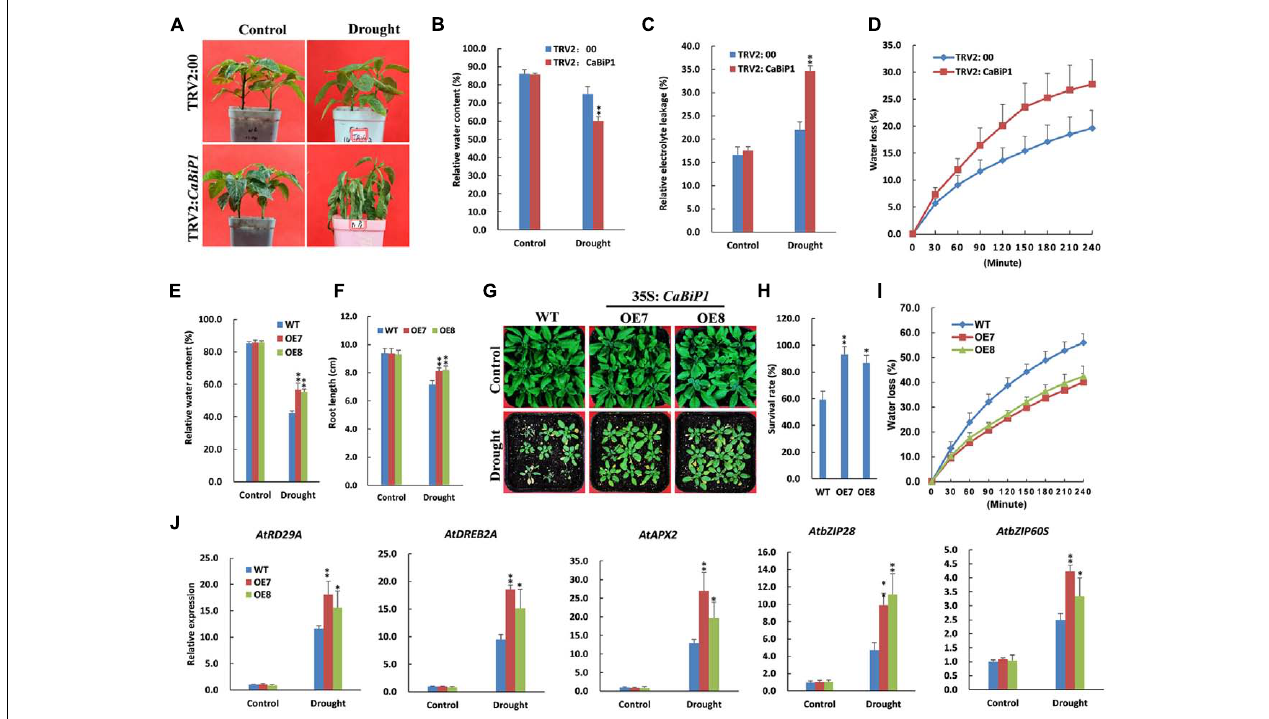
FIGURE 10 | Altered drought tolerance in CaBiP1 -silenced and CaBiP1 -overexpressing plants. (A–C) Symptoms, RWC and REL in the leaves of TRV2: CaBiP1 and TRV2:00 pepper seedlings grown under drought stress performed by withholding water for 10 days. (D) Water loss rate of detached leaves from pepper TRV2: CaBiP1 and TRV2:00 seedlings. (E,F) RWC and root length of WT and CaBiP1 -OE lines grown under drought stress by withholding water for 12 days. (G,H) Survival rate of WT and CaBiP1 -OE lines grown under drought stress by withholding water for 12 days then rehydrated for 2 days. (I) Water loss rate of detached leaves from WT and CaBiP1 -OE seedlings. (J) Expression of drought stress- and ER stress-related genes in the leaves of WT and CaBiP1 -OE lines grown under drought stress by withholding water for 10 days. AtActin2 was used as the internal control gene. Data are the mean ± standard deviation from three biological replicates. Statistical significance is indicated by a single asterisk ( p < 0.05) and a double asterisk ( p < 0.01) based on the Student’s t